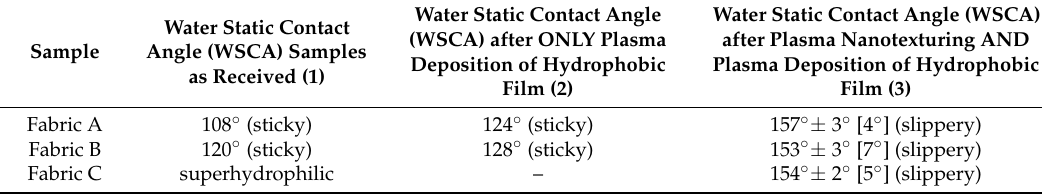
Table 1. Wetting properties of PES fabrics as received (1), after coating with a plasma deposited hydrophobic layer (2) and after plasma processing (3). CAH is given inside brackets. The adhesion behavior of each fabric (sticky, slippery) is given inside parentheses.